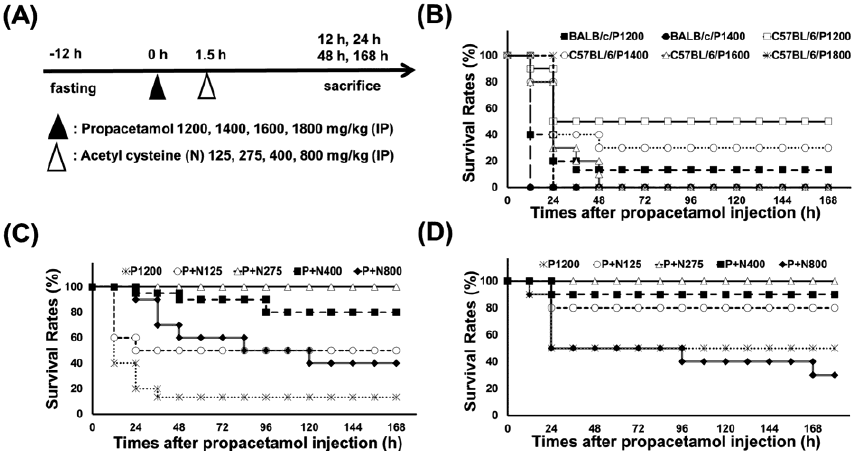
Figure 1. ( A ) Experimental designs and time charts for studying survivals following injections with different propacetamol (P) and N-acetyl cysteine (NAC) (N) doses and the dosage effects of N at indicated time points. ( B ) Survival rates of BALB/cByJNarl (BALB/c) and C57BL/6JNarl (C57BL/6) mice injected with indicated P doses at different time points. The survival rates of BALB/c ( C ) and C57BL/6 ( D ) mice injected with indicated N doses post-1200 mg/kg propacetamol (P1200) injection at different time points.